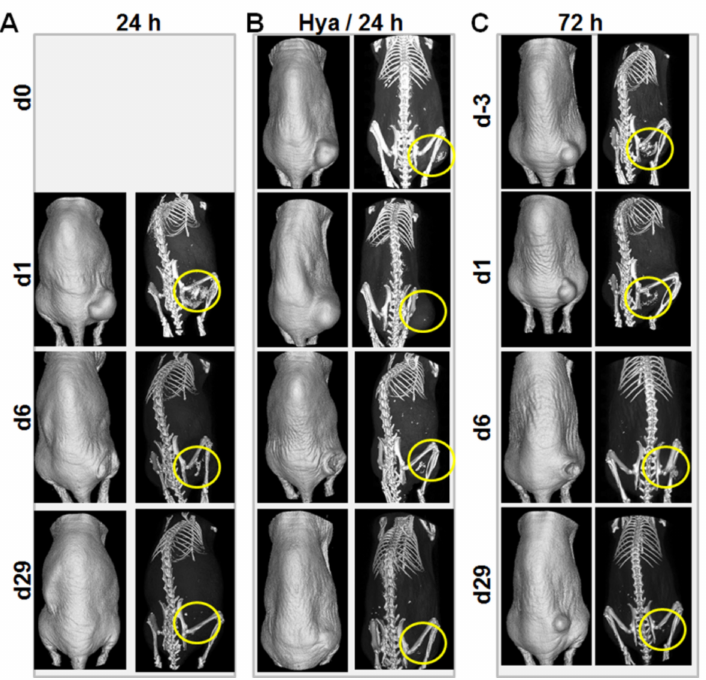
Figure 5. Representative micro-CT images of mice showing Dex-MNP deposits after intratu- moral application and after hyperthermia treatment. All mice received comparable concentrations (0.5 mgFe/100 mm 3 tumor volume) of intratumoral Dex-MNP, which reveal characteristic X-ray den- sities indicated with yellow circles. ( A ) Representative mouse of the 24 h group showing Dex-MNP at 24 h after application (d1) and at days 6 and 29 (d6/d29) after the first hyperthermia treatment. ( B ) Representative mouse of the hyaluronidase treatment group showing Dex-MNP immediately after (d0) and 24 h (d1) after injection, and at days 6 and 29 (d6/d29) after the first hyperthermia treatment. Hyaluronidase I-S (40 µ g/100 mm 3 tumor volume) was injected 2 h prior to Dex-MNP injection. ( C ) Representative mouse of the 72 h group showing Dex-MNP immediately after (d-3) and 72 h (d1) after injection, and at days 6 and 29 (d6/d29) after the first hyperthermia